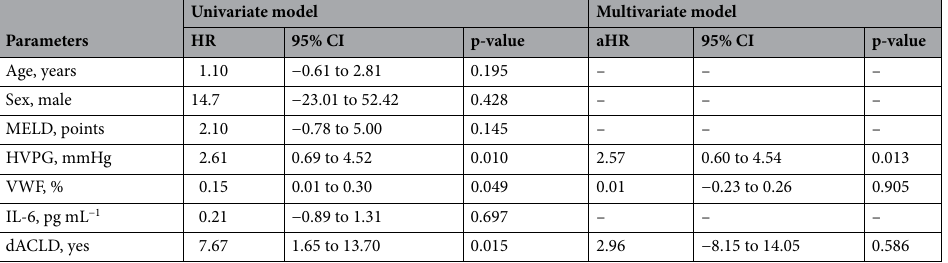
Table 3. Factors associated with Ang 1–7 assessed by linear regression analysis. Both univariate and multivariate regression analyses are shown. Ang angiotensin, HVPG hepatic venous pressure gradient, IL- 6 interleukin-6, LSM liver stiffness measurement, MELD model for end-stage liver disease, vWF von Willebrand factor antigen.